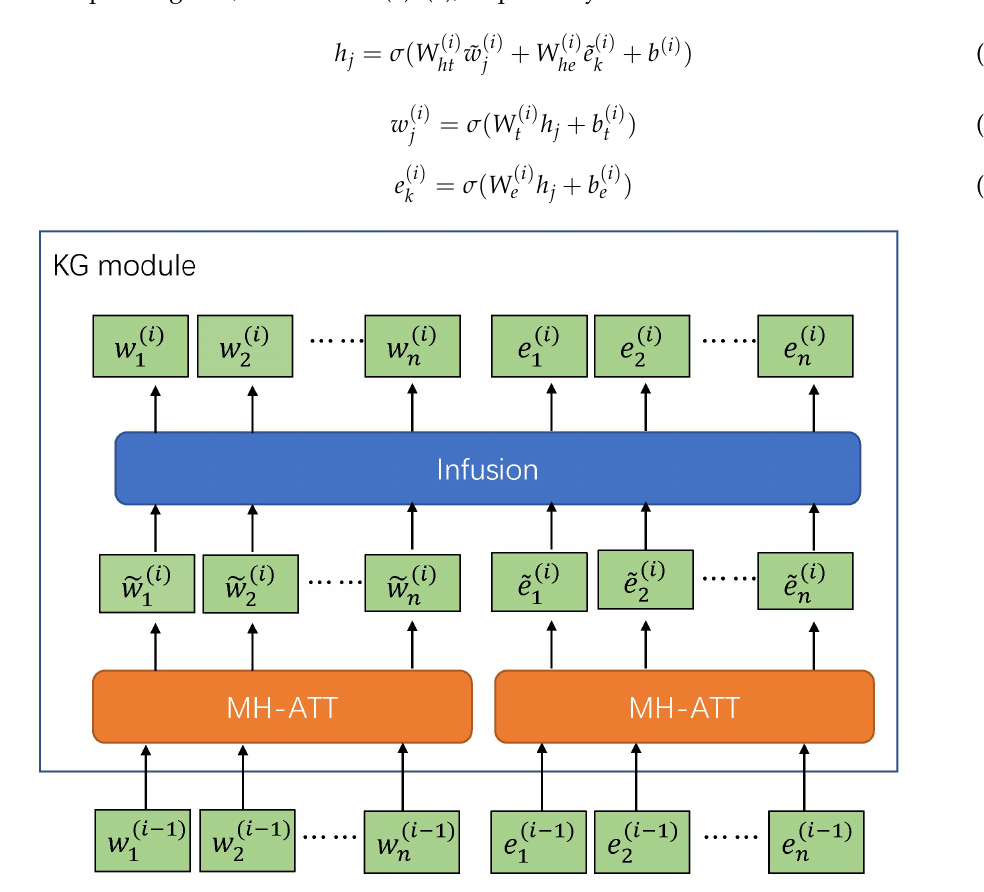
Figure 4. The operational flow of the KG